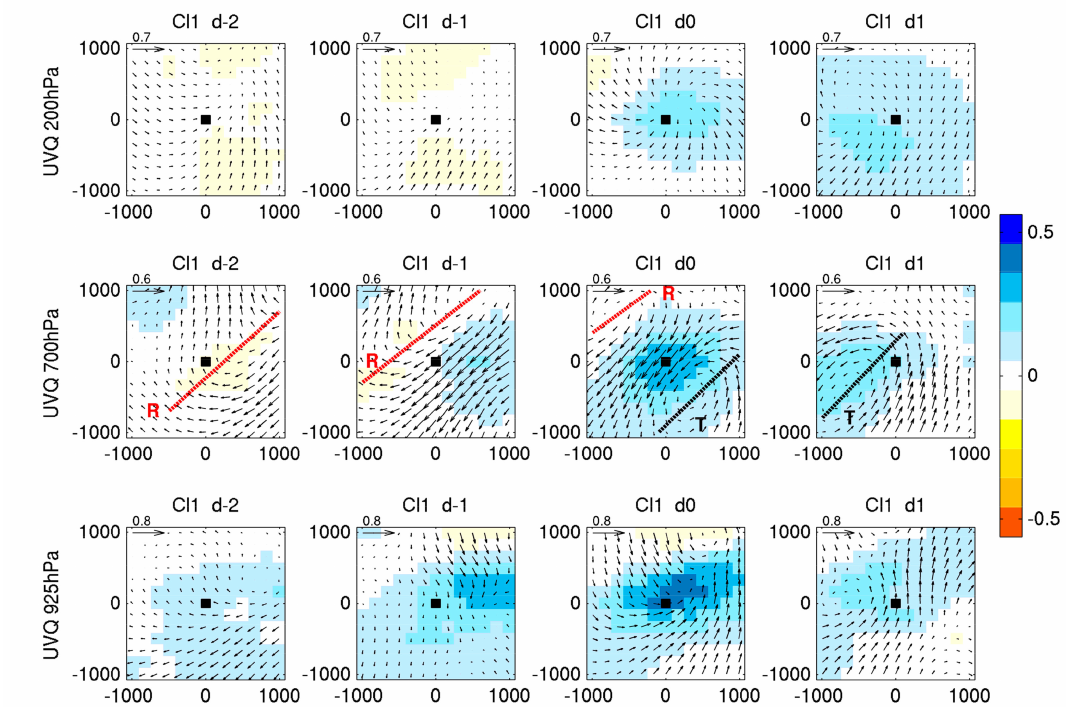
Figure 11. Composite anomalies of wind (vectors) and specific humidity (shadings) associated with intense rainfall events over the continent (cluster 1), from 3 days before to 1 day after the event. Blank: non-significant anomalies (P = 0.999). Units: normalized anomalies on deseasonalised data. Vertical axes are latitudes and horizontal axes are longitudes, scaled in kilometers from the grid-point where the rainfall event occurs (P, black square). Dashed lines show the approximate location of 700 hPa ridges (R) and troughs